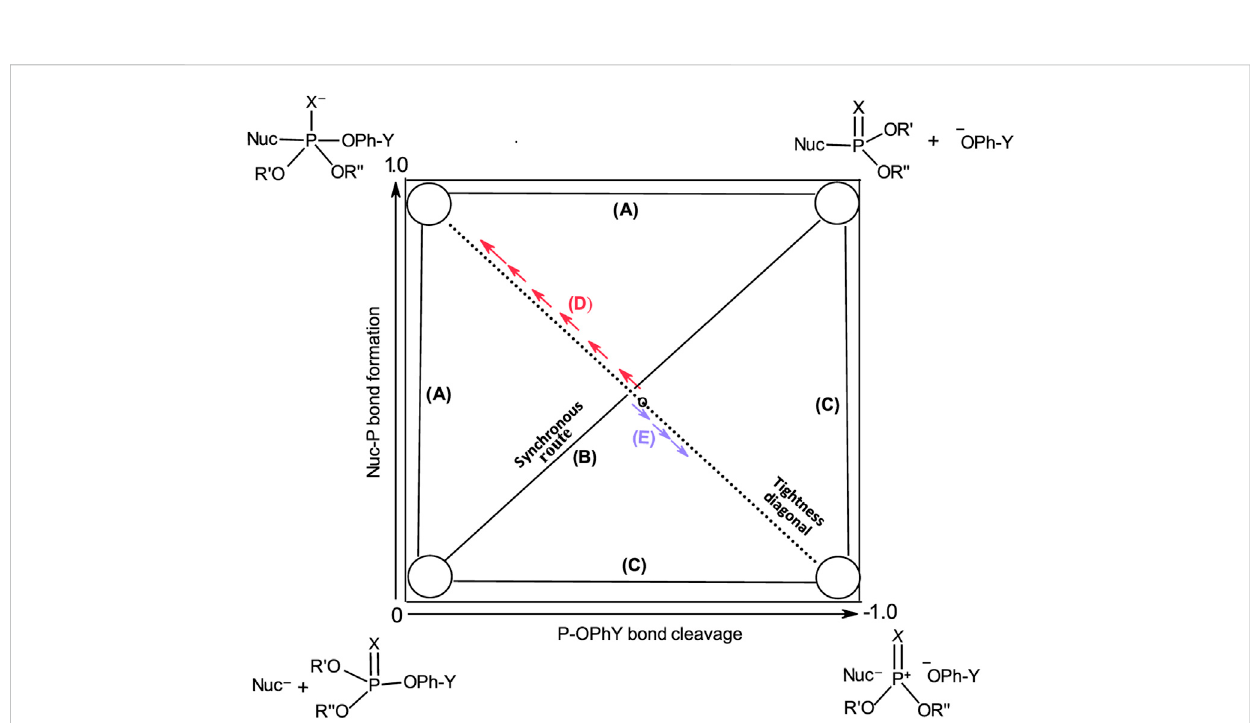
FIGURE 2 A More O ’ Ferrall-Jencks diagram for the reaction of a nucleophile with a hypothetical phosphate/phosphorothioate triester ( 3a / 3b ) showing the three mechanistic pathways in Figure 1 as (A – C) .